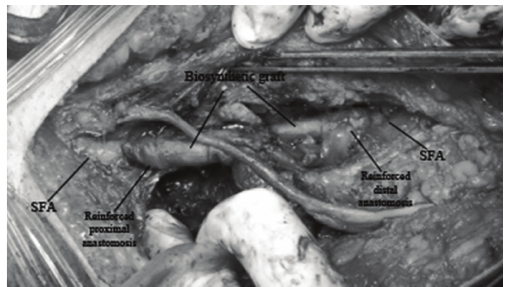
Figure 3: Excision of the destructed segment of the superficial femoralarteryandbiosyntheticgraftinterpositionwithanastomosis sites reinforcements ( SFA, superficial femoral